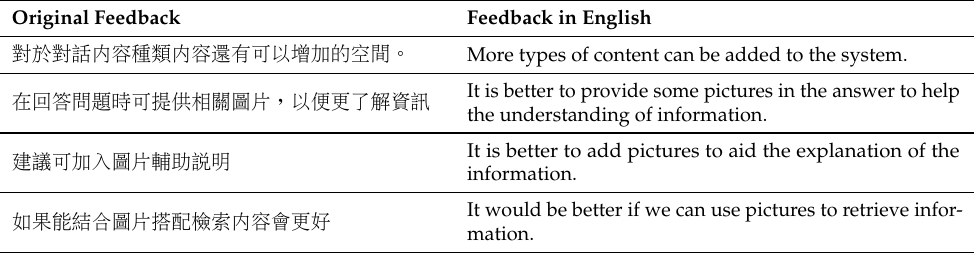
Table 14. Disadvantages of AidIR.